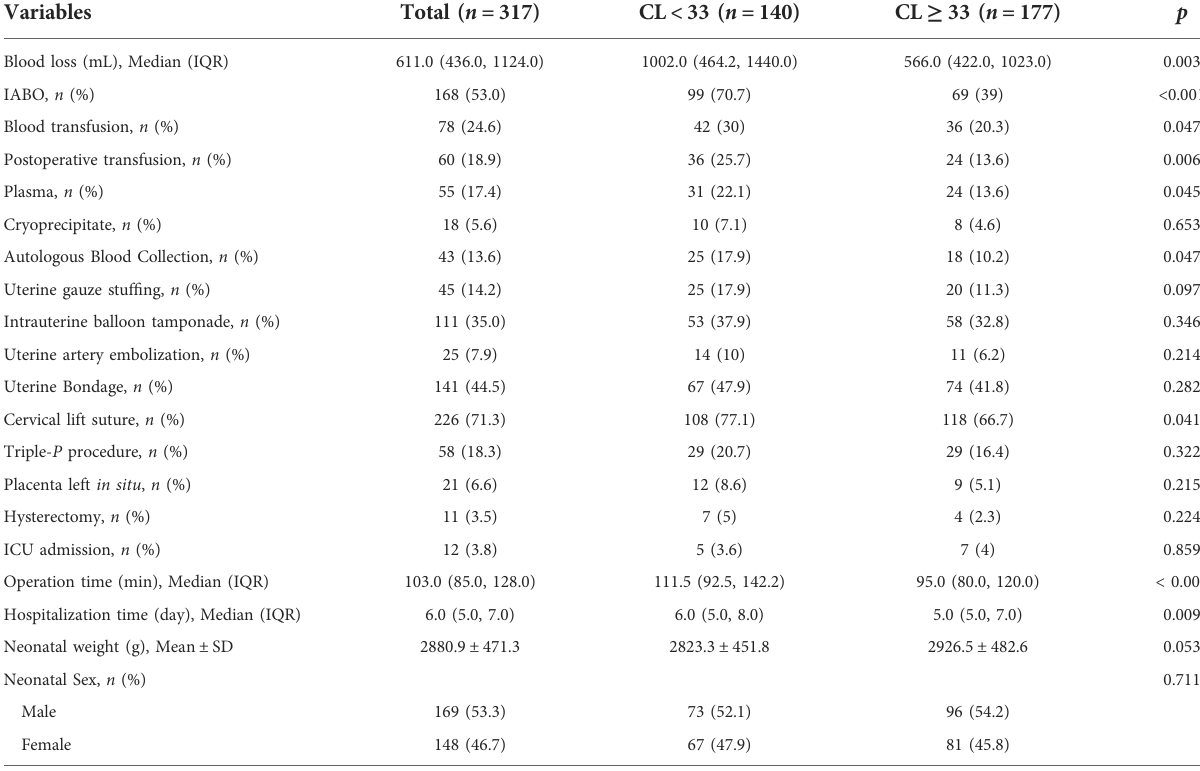
TABLE 2 Intraoperative and postoperative data of the study participants.